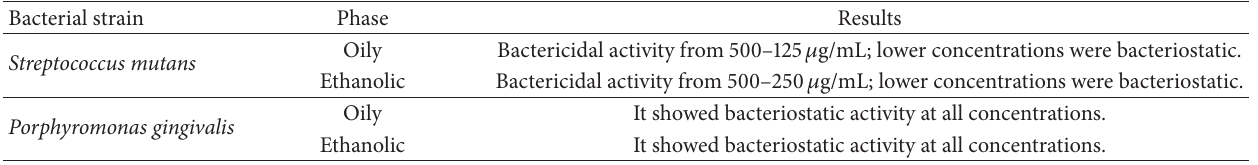
Table 1: Minimum bactericidal concentration MBC from the oily and ethanolic phases against Streptococcus mutans and Porphyromonas gingivalis strains.